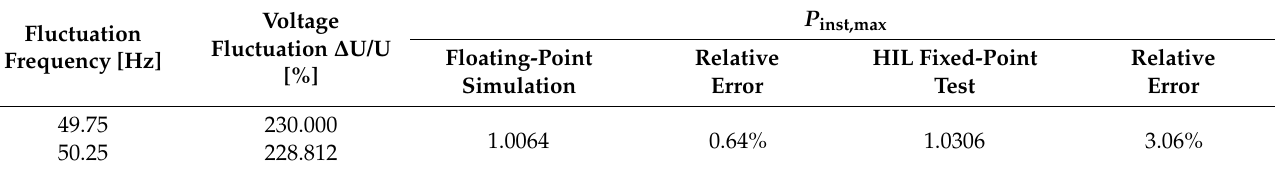
Table 5. Combined frequency and voltage